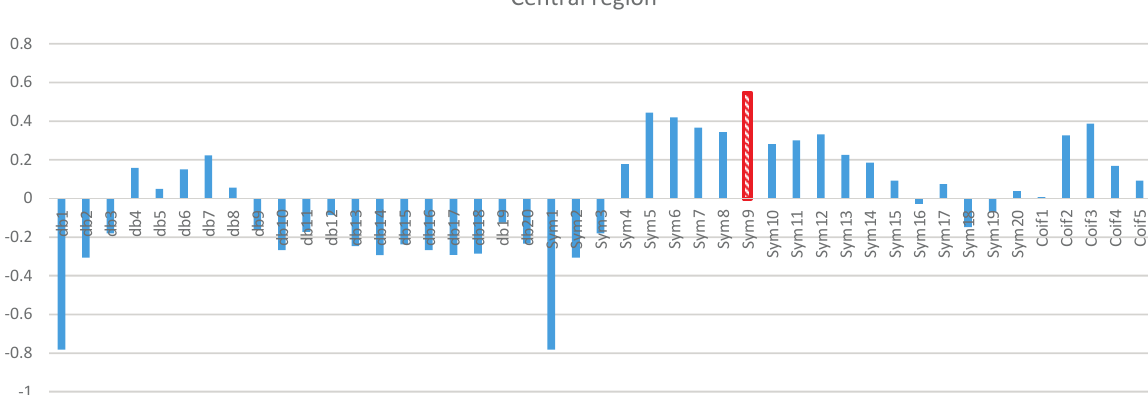
Figure 11. Comparative plot of correlation coefficients with 45 mother wavelet filter for the central region of the brain for 10 control